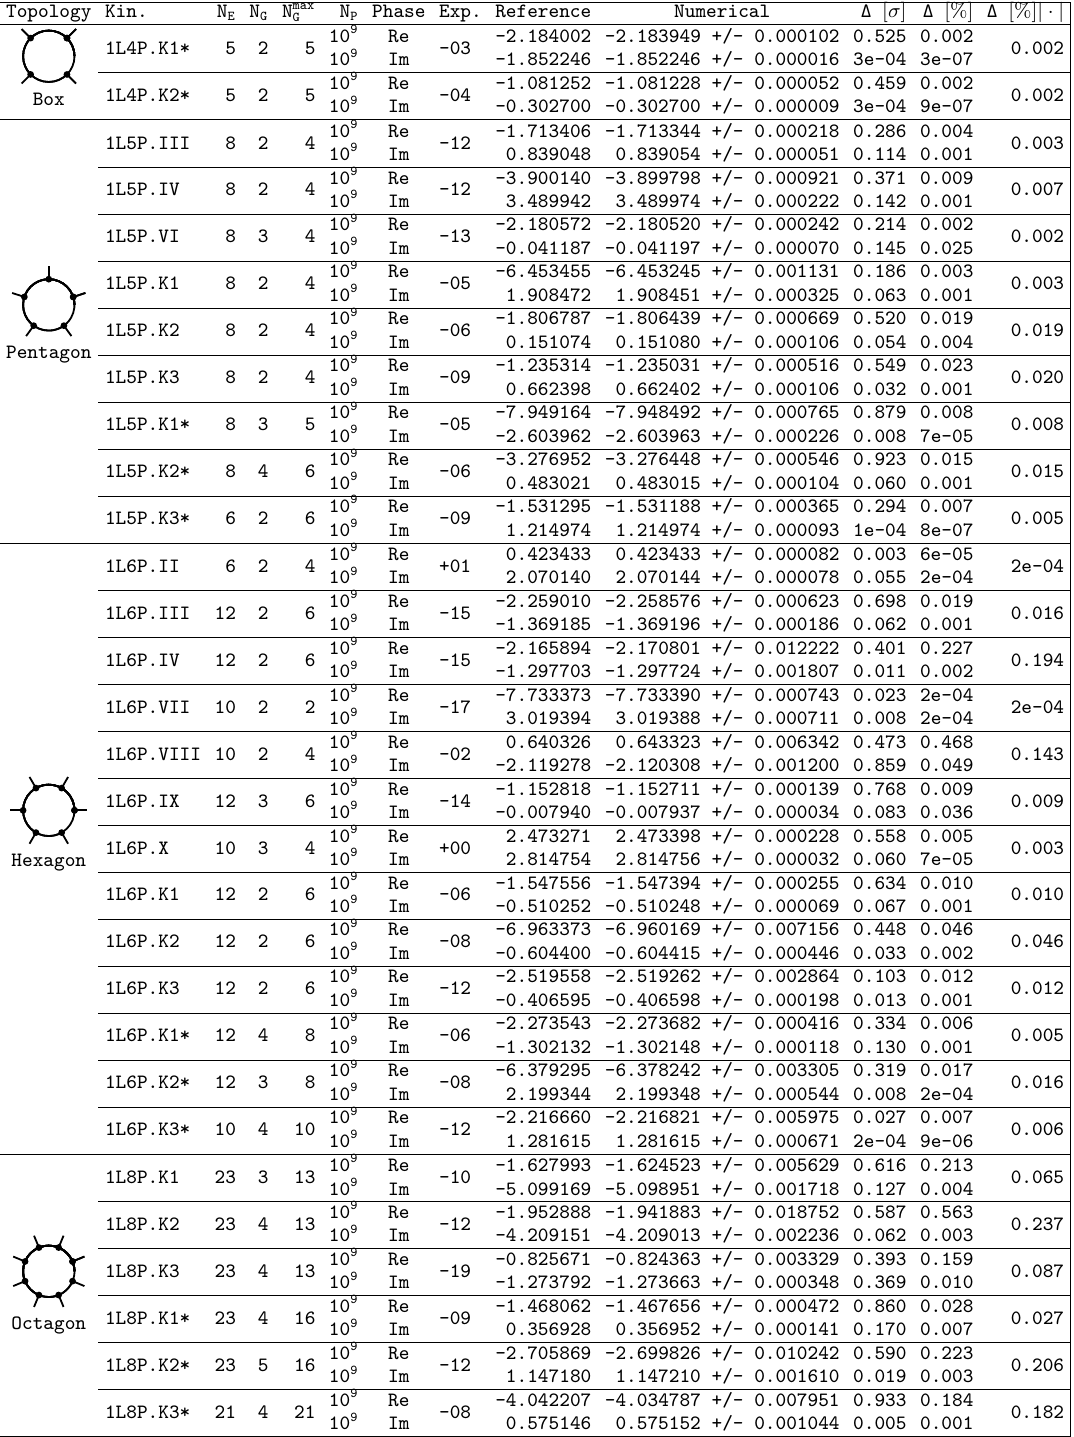
Table 3. Scalar one-loop integrals for various kinematic configurations that require grouping of counterterms and residues, according to eqs. (3.44) and (3.45), to fully realise local